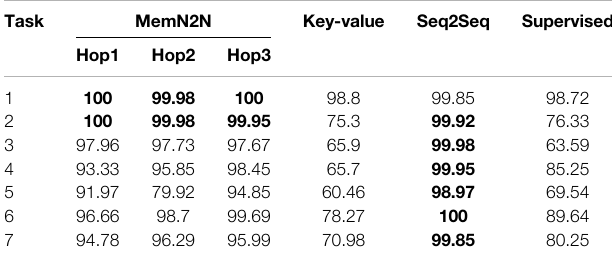
TABLE 2 | The test set results of the Barista Dataset with 1,000 dialogues. The best performing methods (or methods within 0.1% of best performing) are given in bold for the per-response accuracy metric. The results show that on average and for task 7 (containing all tasks), Seq2Seq is the best performing model, providing near-perfect